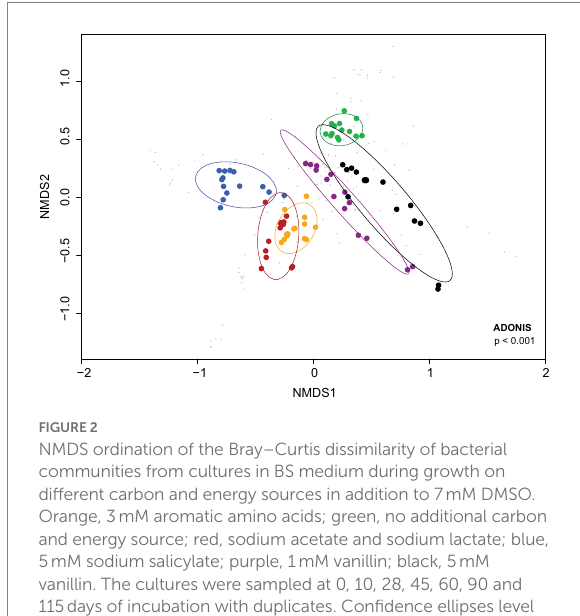
FIGURE 2 NMDS ordination of the Bray–Curtis dissimilarity of bacterial communities from cultures in BS medium during growth on different carbon and energy sources in addition to 7 mM DMSO. Orange, 3 mM aromatic amino acids; green, no additional carbon and energy source; red, sodium acetate and sodium lactate; blue, 5 mM sodium salicylate; purple, 1 mM vanillin; black, 5 mM vanillin. The cultures were sampled at 0, 10, 28, 45, 60, 90 and 115 days of incubation with duplicates. Confidence ellipses level at 0.95. values of p are at the lower right corner of the